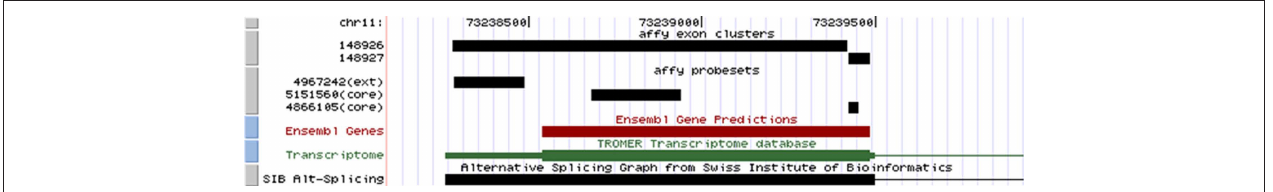
FiguRe A1 | illustration of Affymetrix transcript structure vs. Ensembl transcript structure. Olfr378 is annotated in Ensembl as a single exon gene on the ( − ) strand. However, Affymetrix specifies two “exon clusters” (148926 and 148927) and two corresponding core probesets, one of which is highly expressed (4865105) and one of which is not (5151560). Analyzing the data using this transcriptional structure would be misleadingly interpreted as exon shut-off of second exon cluster.